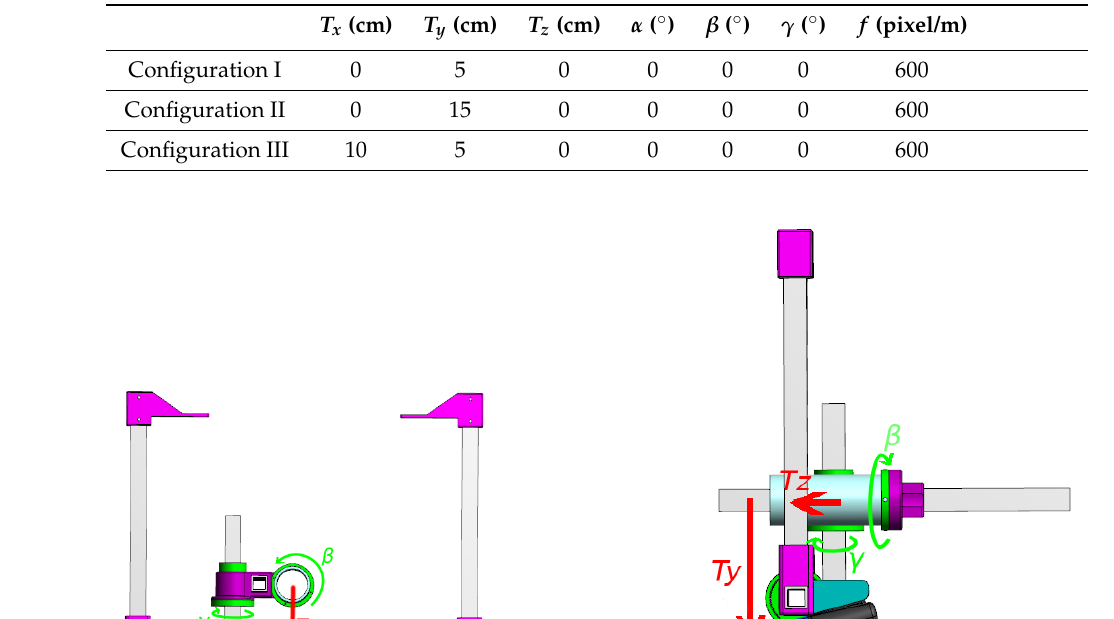
Table 2. The three geometric configurations of the sensors available in the dataset.